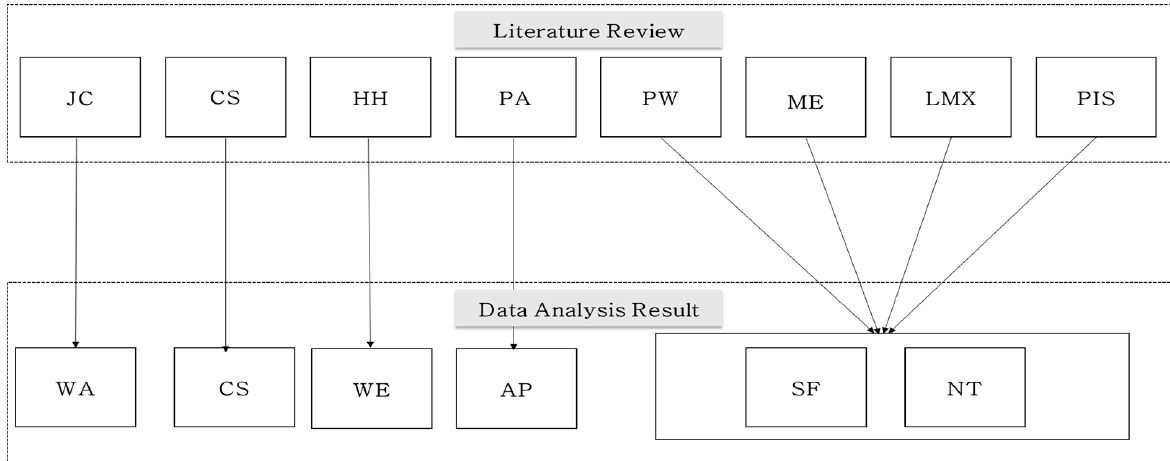
Figure 2. Result of scale development.